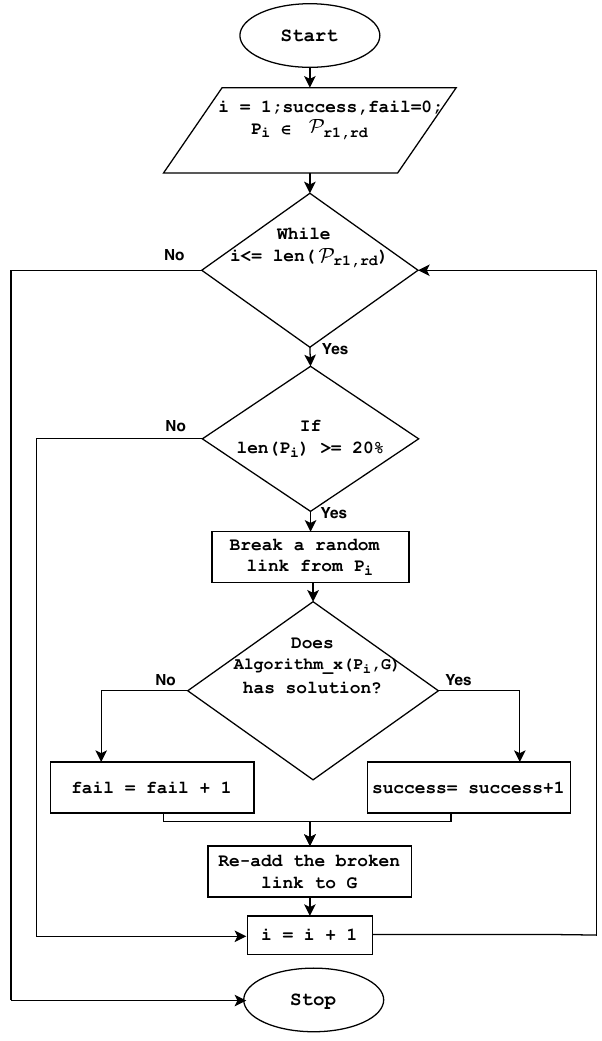
Figure 7. Flowchart for calculating Success and Fail